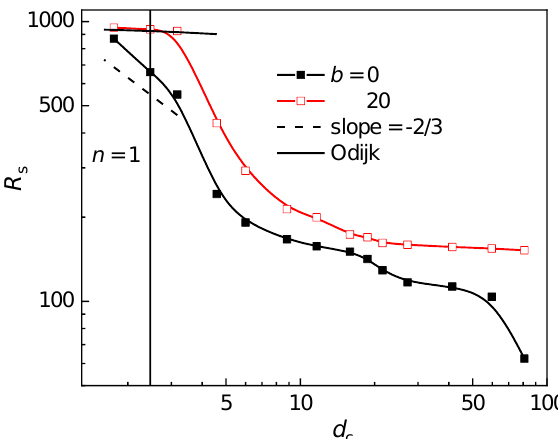
Figure 4. Axial chain extension of a flexible ( b = 0) and semiflexible ( b = 20) chain in a post array with the geometry variation at constant post diameter d p as a function of the size of the interstitial volume d c in a logarithm scale. The solid vertical line demarcates the region with the dominance of single-occupancy for both chains.